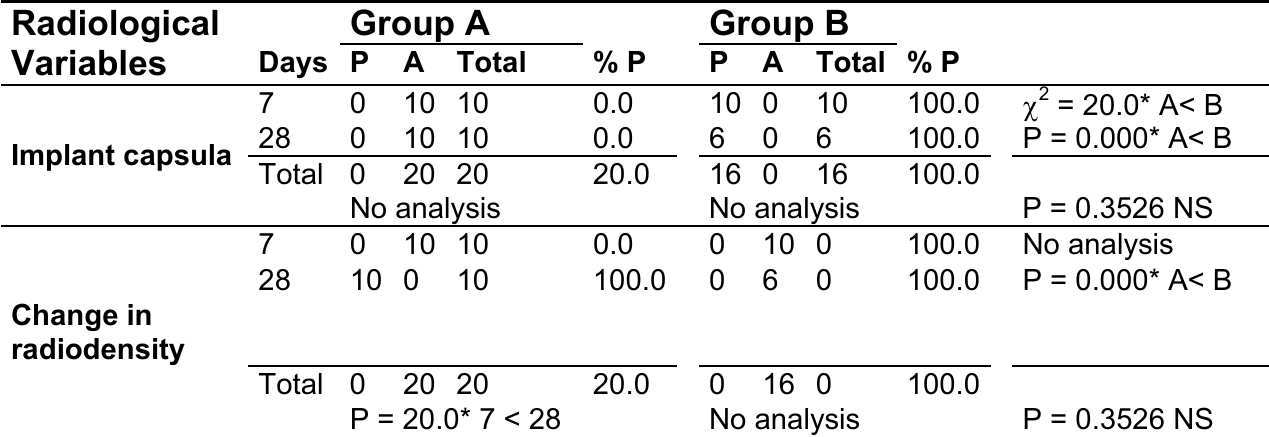
TABLE 2 - Radiological variables in the implants, according to the presence (P) or absence (A) of pseudo-capsule and change of radio